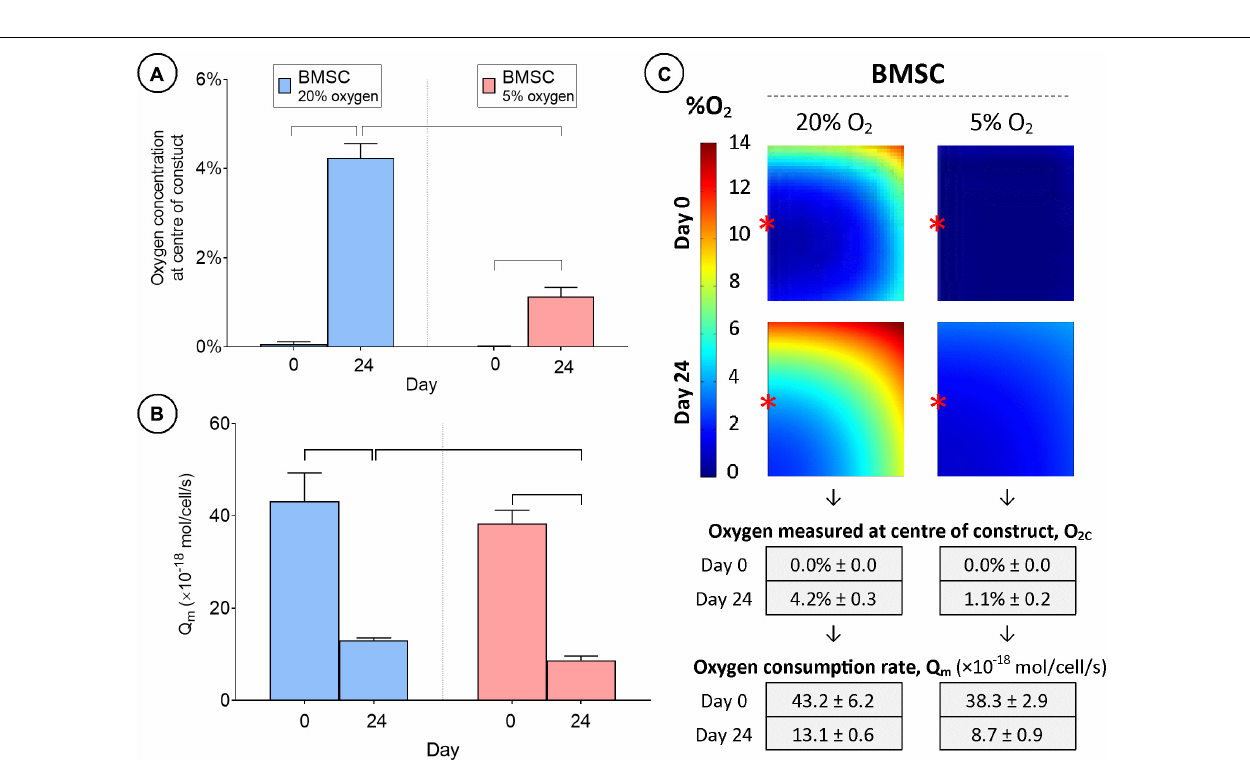
FIGURE 6 | Cartilage tissue grafts engineered using bone marrow MSCs were cultured in either a 20% or low (5%) external oxygen environment for 24 days. (A) Oxygen concentration at center of constructs. (B) Cellular oxygen consumption rate extrapolated from FE model. (C) FE contour plots showing predicted oxygen gradients and table of values from (A,B) ( ± SD). Significant differences between groups are indicated where P < 0.05 ( n = 3). ∗ Indicates the location of oxygen sensor measurement within the constructs.